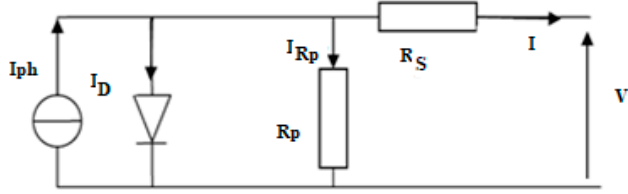
Figure 2. Electric model of a PV cell.